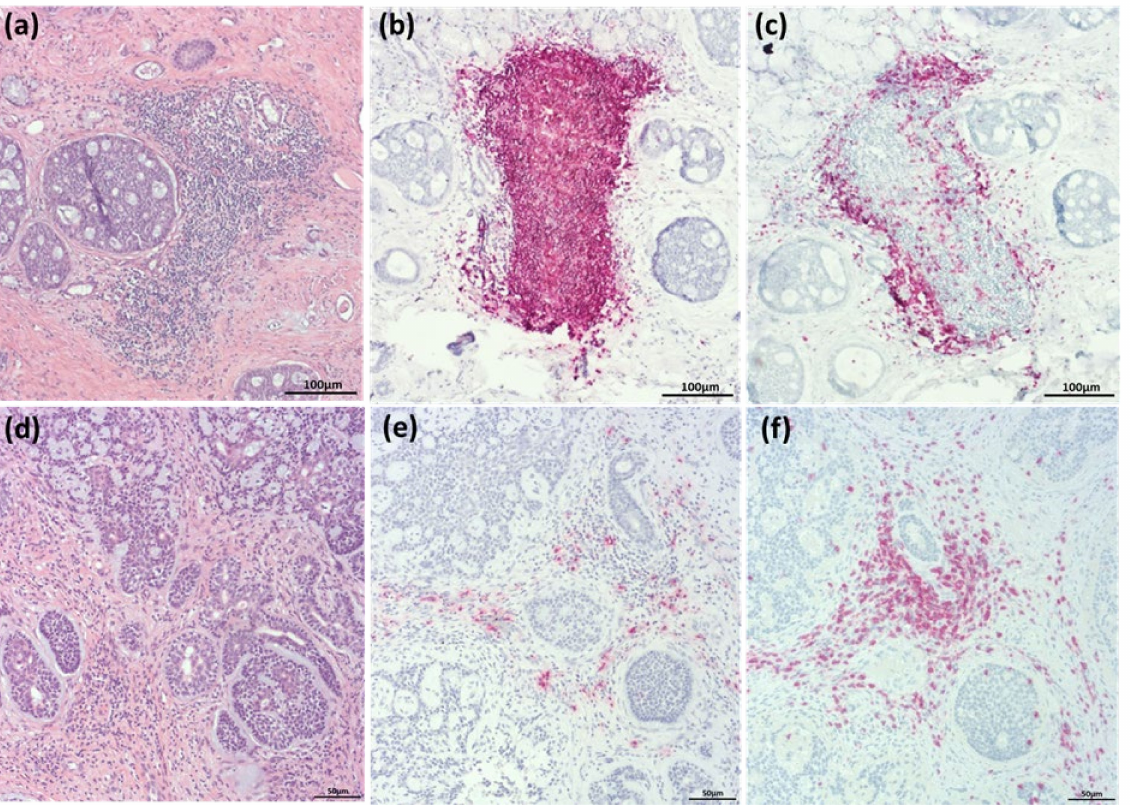
Figure 1. Examples of ACC of the submandibular gland ( a ) (HE) and the nasal cavity ( d ) (HE), categorized into infiltrated-inflamed with TLS ( a – c ) and infiltrated-inflamed without TLS ( d , e ). Corresponding immuno-histochemistry for CD20 is shown in ( b , e ), for CD3 in ( c , f